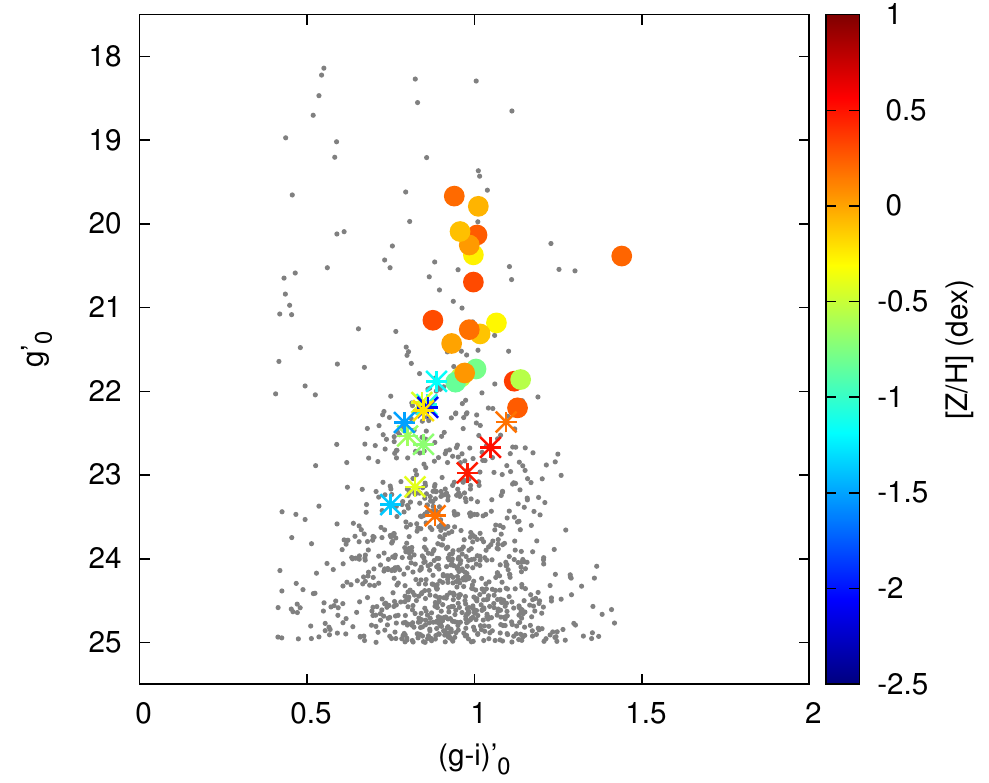
Figure 3. Color-magnitude diagram of the photometric GCs candidates ([3]). The grey dots correspond = 25mag. The colors indicate the different metallicities of the to the GCs candidates brighter than g (cid:48) 0 35 spectroscopically confirmed GCs. We distinguish between GCs with spectra with S/N <25 (stars) and S/N >25